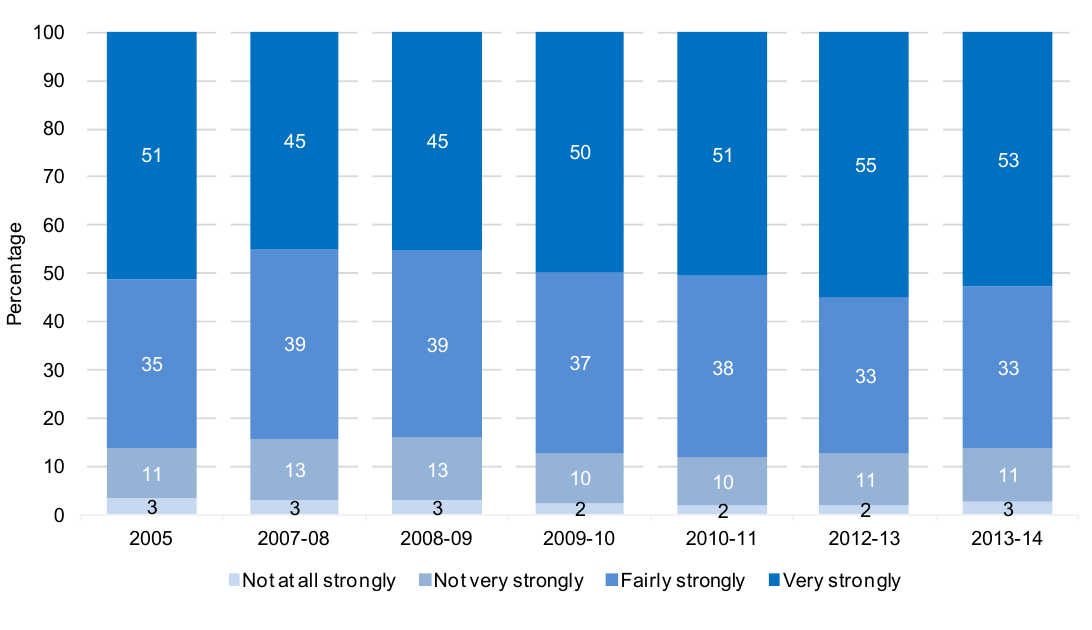
- Table 10: Whether people feel that they belong strongly to their neighbourhood and Britain, 2003 to 2013-14